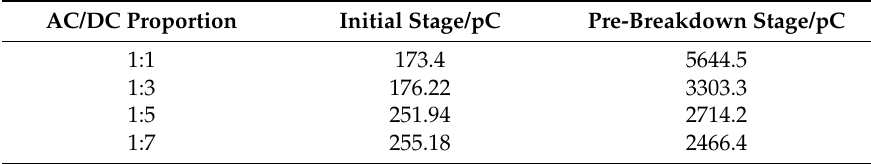
Table 3. Relationship between Max PD amplitude AND AC/DC